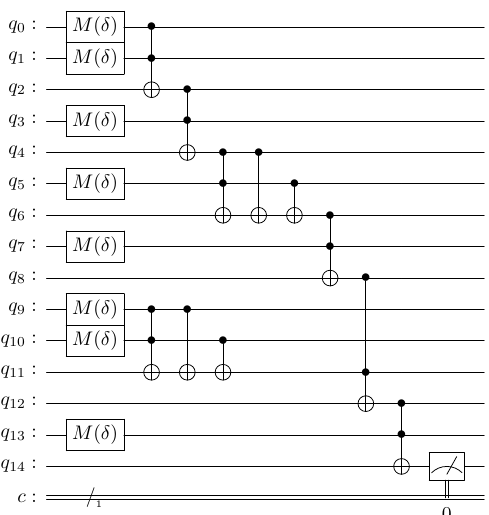
Figure 15. The quantum inferential circuit modified for the imprecision and uncertainty experiment. The Hadamard gates of quantum lines q 0 , q 1 , q 5 , q 9 , and q 10 were replaced by M ( δ ) gates, so as to configure inaccurate inputs. The Hadamard gates of quantum lines q 3 , q 7 , and q 13 were substituted by M ( δ ) gates so as to configure inaccurate